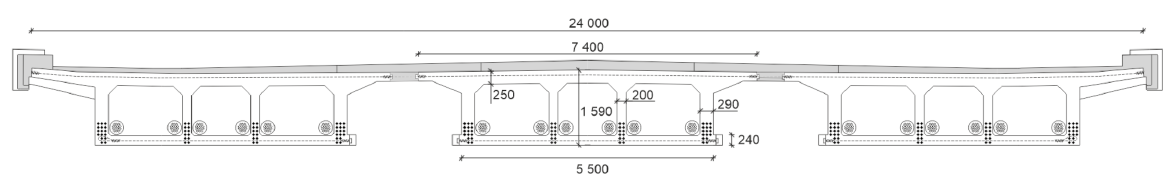
Figure 1. Cross-section view in the mid-span of the Wonka bridge.